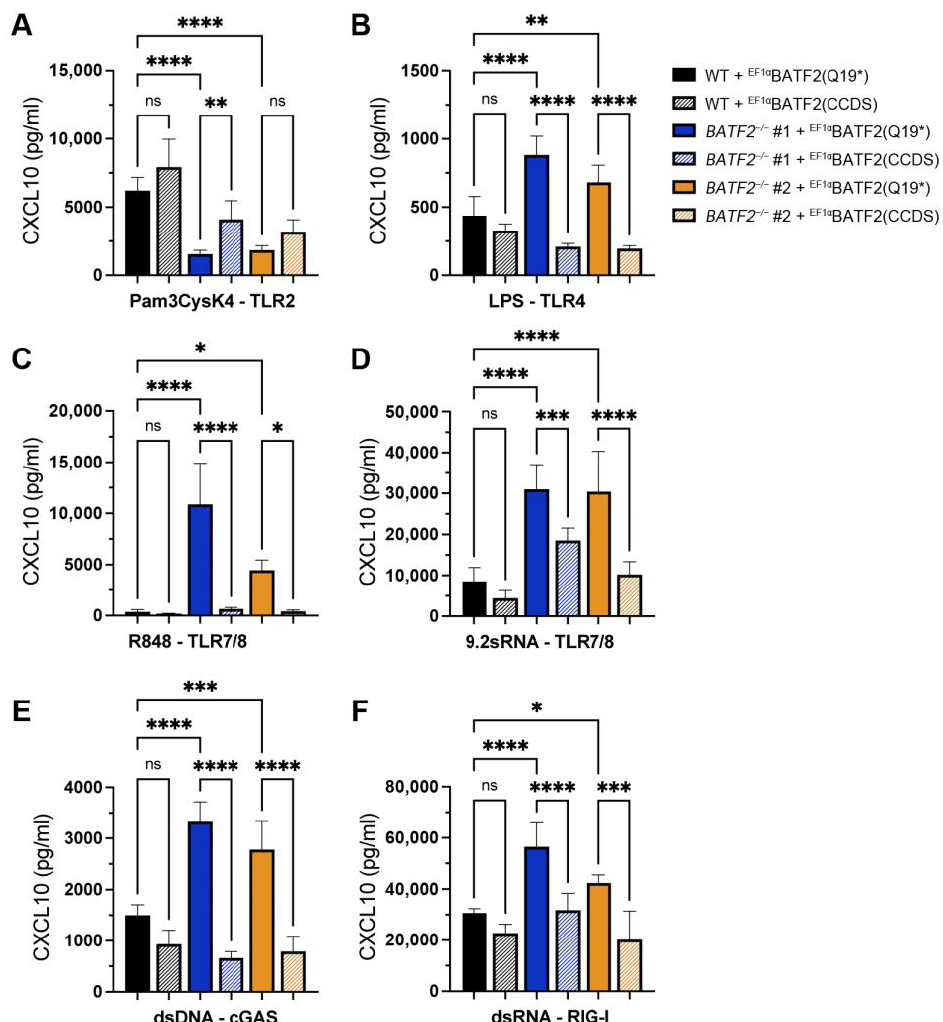
Figure 4. Rescue of TLR7/8, cGAS, and RIG-I responses by lentiviral expression of wild-type BATF2. Wild-type and BATF2 − / − THP-1 cells ectopically expressing wild-type or p.Gln19* mutant BATF2 were stimulated with 2 µ g/mL Pam3Cys ( A ), 2 µ g/mL LPS ( B ), 500 ng/mL R848 ( C ), 2 µ g/mL 9.2 sRNA ( D ), 250 ng/mL dsDNA ( E ), or 100 ng/mL 3pdsRNA ( F ). Cellular supernatants were harvested for CXCL10 ELISA. Arithmetic mean ± SEM from three independent experiments is presented. Statistical significance was analyzed via a one-way ANOVA with Šid á k’s correction. *, p < 0.05; **, p < 0.01; ***, p < 0.005; ****, p < 0.001.